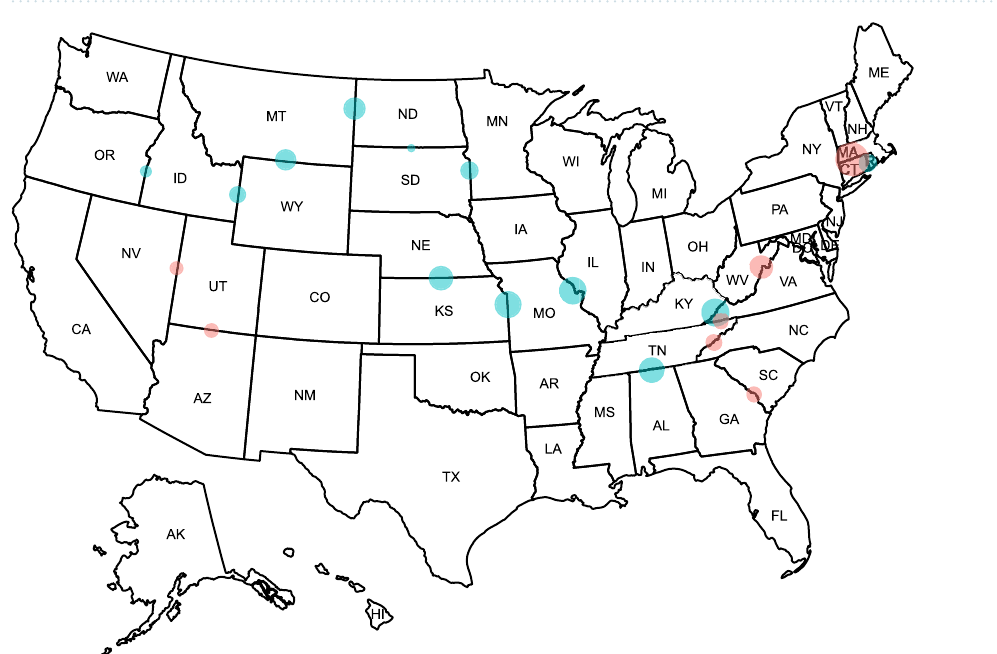
Figure 3. The heterogeneity of face mask mandate effects for use in businesses in terms of home dwell time (in minutes) across state borders. We use the differences-in-differences methods for each pair. The control states are no-policy states or have policies after 2 weeks of the corresponding treatment states. Blue dots imply the treated states demonstrate risk compensation behaviors and red dots imply evidence for the opposite effect. The dot sizes are the magnitudes of the coefficients. We only show the results for precisely estimated pairs using a 95% confidence level. The detailed table results are in Table